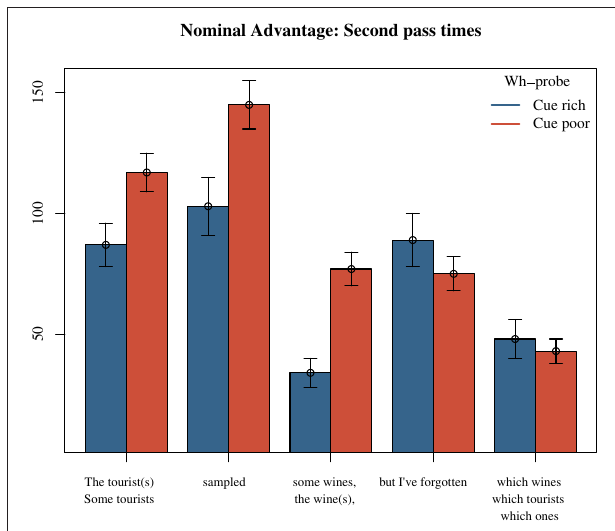
FIGURE 2 | Experiment 2: effect of Locality on the remnant region. Nominal advantage in second pass re-reading times. Times presented in ms.